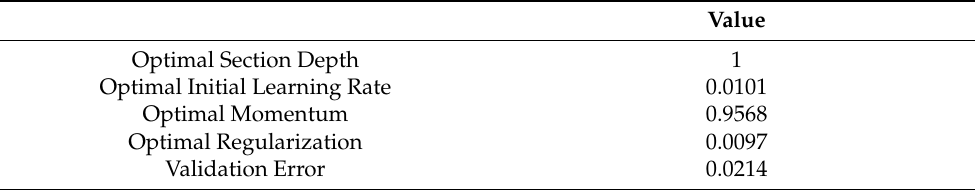
Table 10. Optimal CNN parameters values using BA (final version).